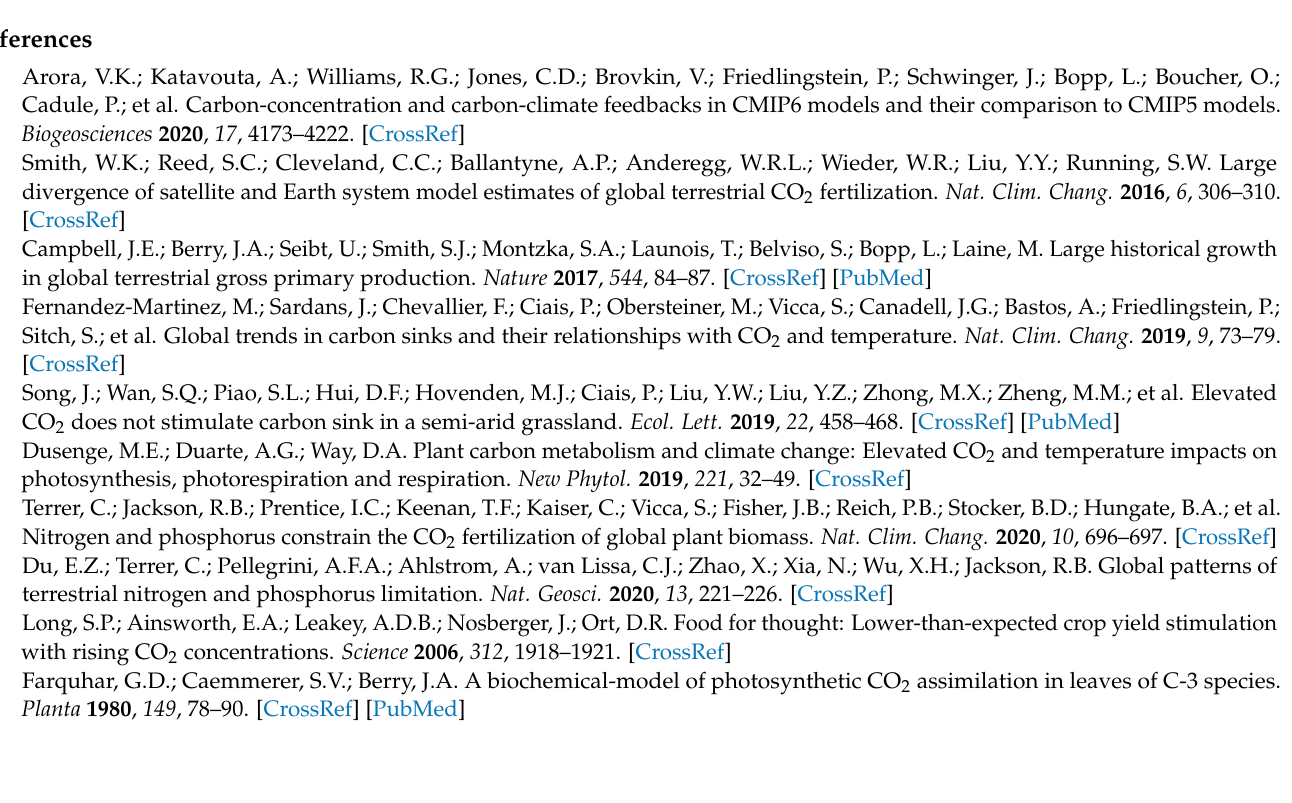
the 22 CMIP6 models; Figure S2: Spatial distributions of annual total NPP differences (TgC year − 1) between abrupt-4 × CO 2 and pre-industrial simulation for the 23 models; Table S1: The selected CMIP6 models and corresponding references